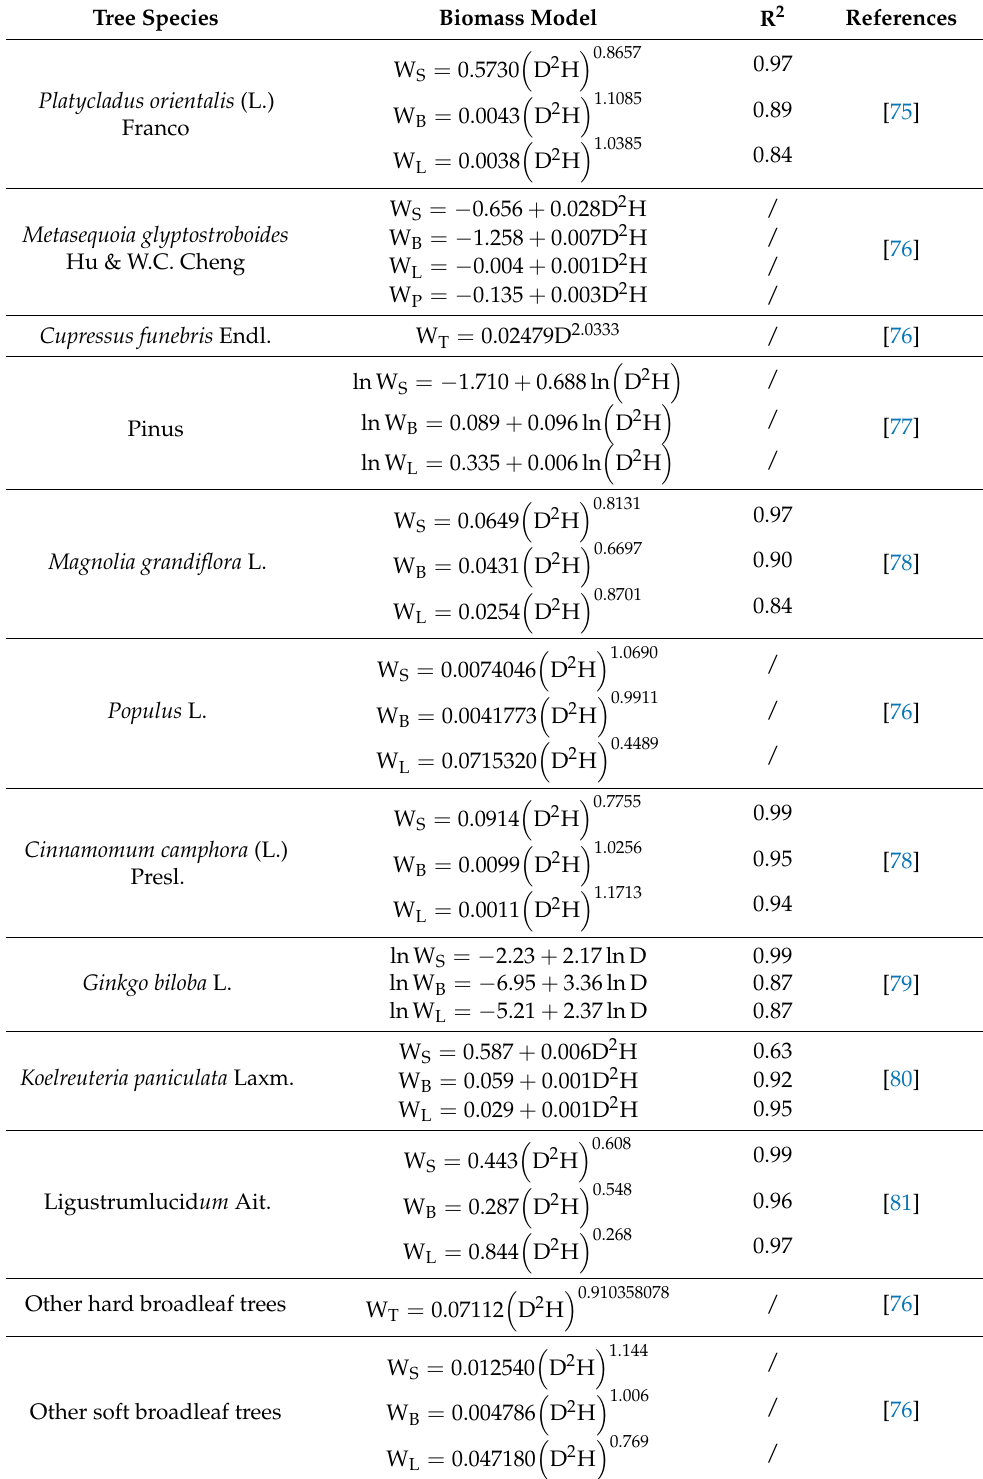
Table A1. Tree allometric growth equation for calculating quadrat above-ground biomass of trees. Tree